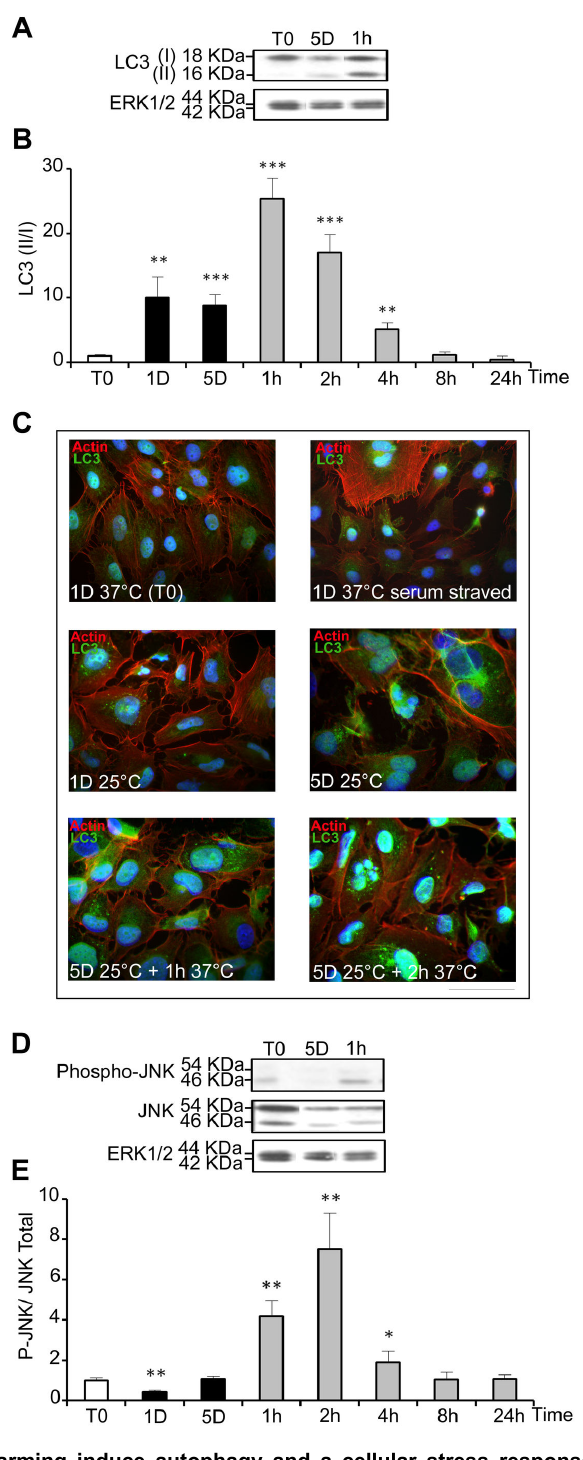
Figure 5. Cold shock and rewarming induce autophagy and a cellular stress response. The level of LC3 I and II (A), phospho-JNK (P-JNK) and total JNK (D) was analyzed by western blot in cells cultured at 25°C for 1 and 5 days and then warmed- up at 37°C for 1 to 24h. The levels of ERK1/2 were taken as calibrator and used to monitor protein loading. Results are expressed as the mean ratio of LC3 II/I (B) and of P-JNK/ total JNK (D) taking T0 as 1. (C) Immunostaining of LC3 was performed in WI26 cells maintained at 37°C in the presence or in the absence of serum or at various time points during the cold shock and rewarming. Actin stress fibers appear in red, LC3 in green and nucleus in blue. Bar: 100µm. doi: 10.1371/journal.pone.0069687.g005 PLOS ONE |